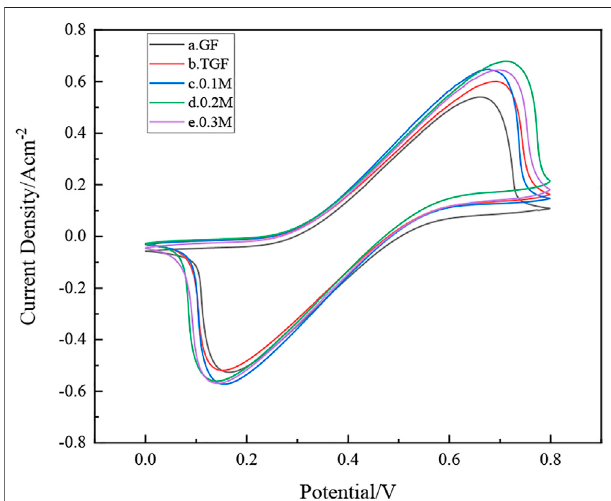
FIGURE 6 | how ’ s samples (a), GF; (b), TGF; (c), heat-treated graphite felt after immersion in 0.1 M InCl 3 solution; (d), heat-treated graphite felt after immersion in 0.2 M InCl 3 solution; (e), heat-treated graphite felt after immersion in 0.3 M InCl 3 solution, cycle Voltammetry curve.